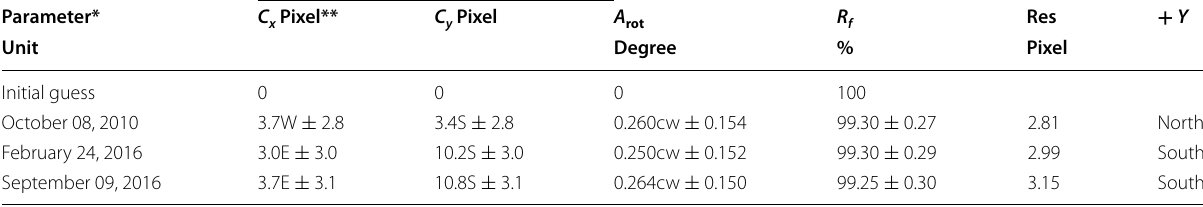
C x and C y are the center of the field of view (in unit of pixel); A rot is field rotation angle (degree); R f is focal length ratio (%); Res is fitting residual (pixel); and spacecraft direction, where 1 pixel 0.0117°. “Initial guess” means the expected parameter value for exact camera setting = *Center of the field of view ( C x , C y ), field rotation angle ( A rot ), focal length ratio ( R f ), fitting residual (Res) and spacecraft direction ( **1 pixel =